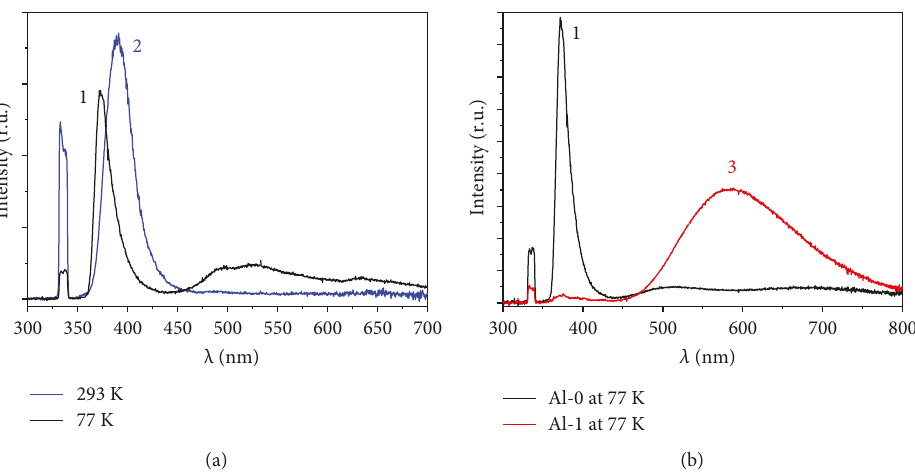
Figure 8: Photoluminescence spectra of ZnO:Al coatings deposited from zinc-aluminum nitrate electrolytes. (a) PL spectra for Al-0 (Al-free) fi lms at 1 — 77 K and 2 — 293K. (b) The PL spectra of 1 — Al-0 and 3 — Al-1 (1 at.% of Al (theoretical)) collected at 77K. The excitation wavelength of 337